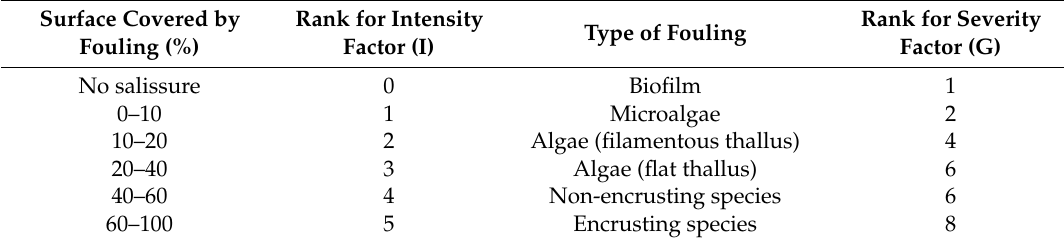
Table 5. Determination of efficiency parameter N